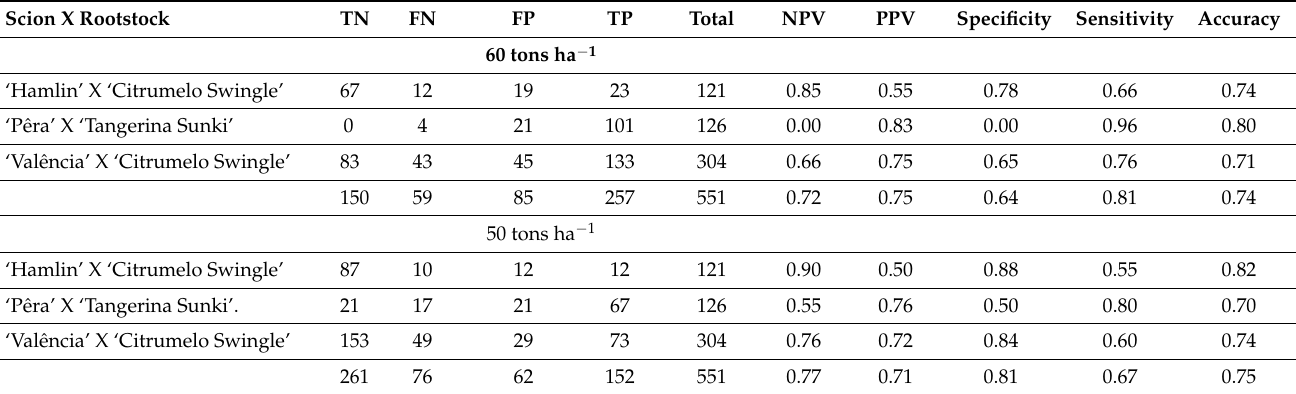
Table 6. Partitioning of the true negative (TN), false negative (FN), false positive (FP), and true positive (TP) results among scion X rootstock combinations in the confusion matrix of the binary random forest model that included all features.